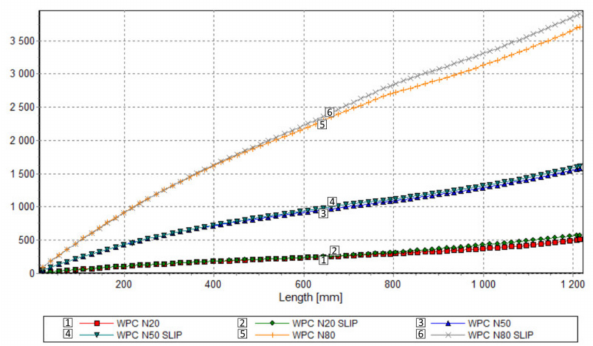
Figure 14. Process simulation: Power consumption profile.